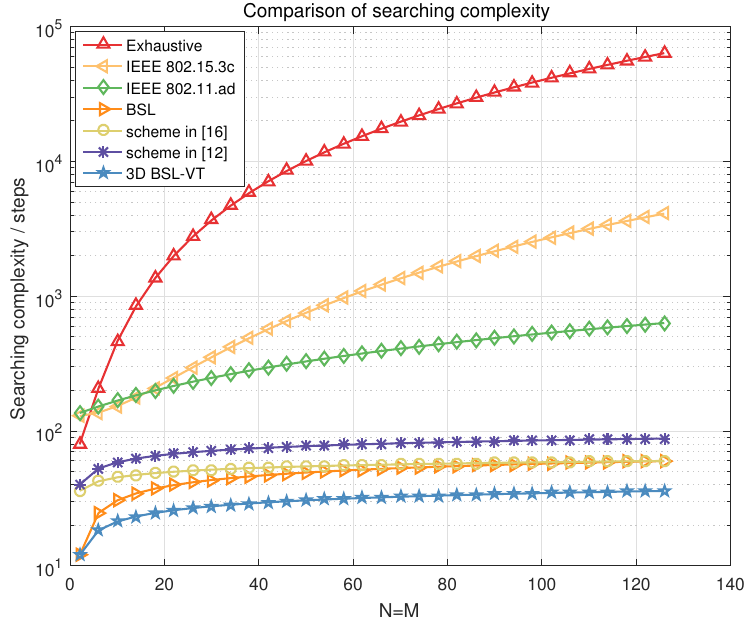
Figure 9. Comparison of the complexity between different beam training